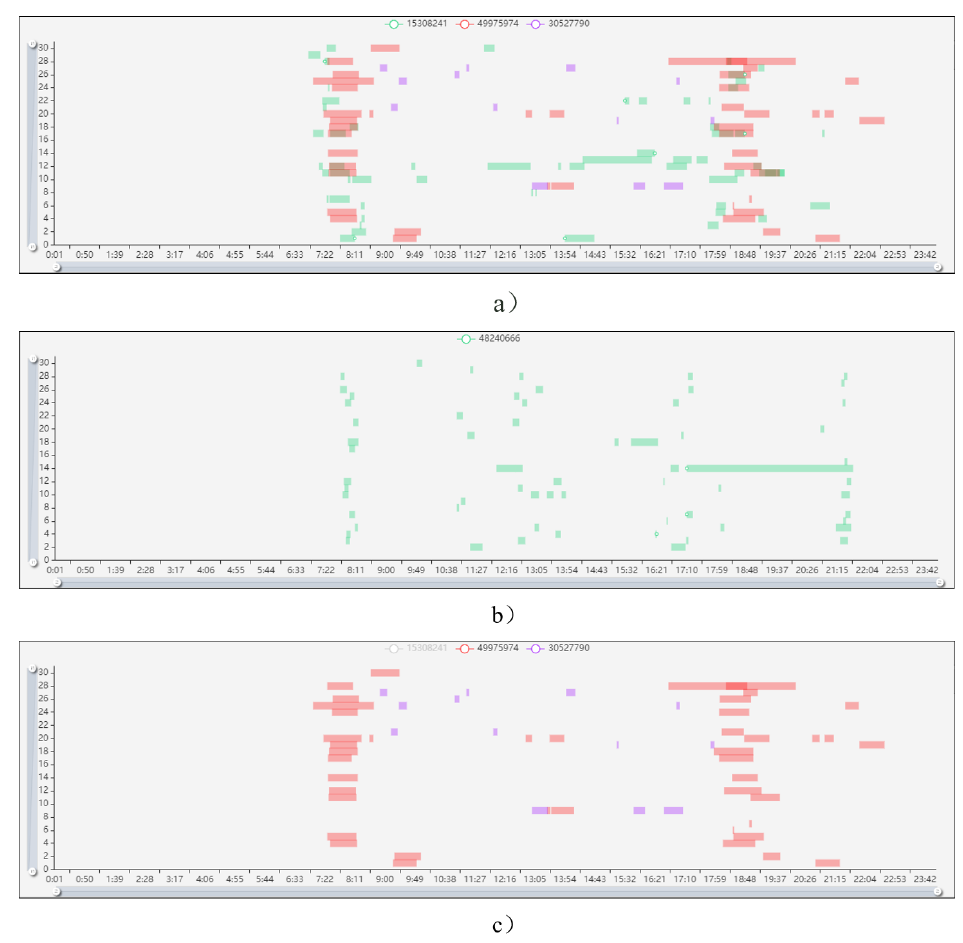
Figure 2. Passenger travel time pixel matrix view ( a ) Multiple IC card, ( b ) Single IC card, ( c ) When the card number 15308241 is hidden.